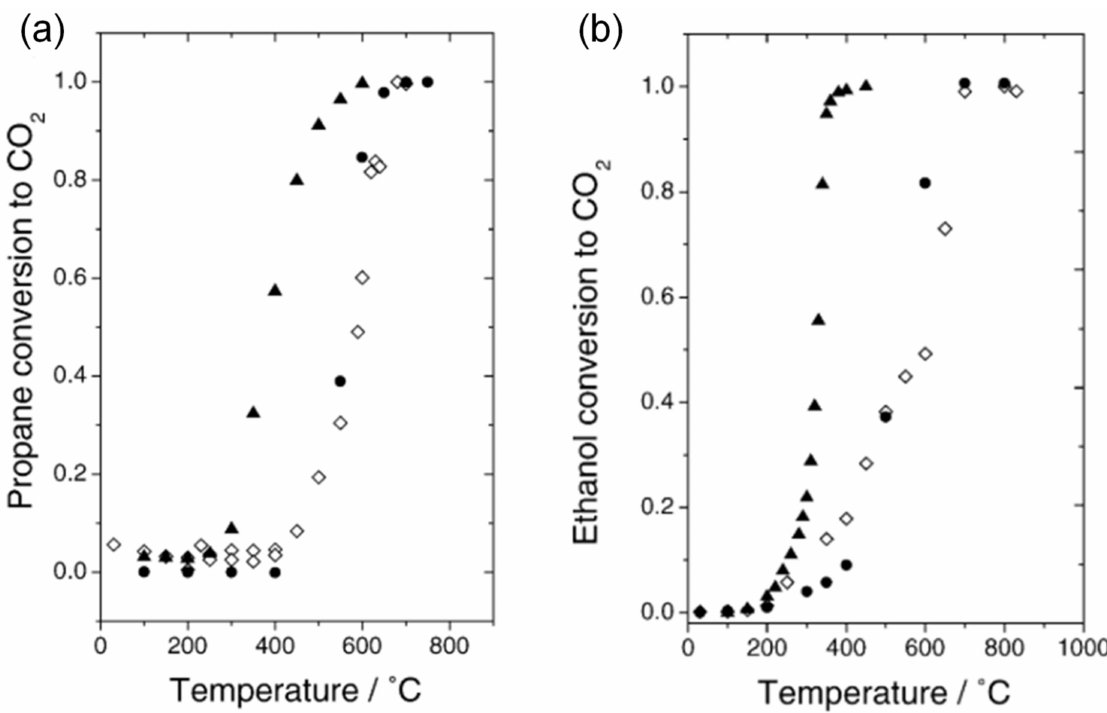
Figure 7. Catalytic tests for total oxidation of propane ( a ) and ethanol ( b ) over the steel slices. ( • ) In free reactor, (